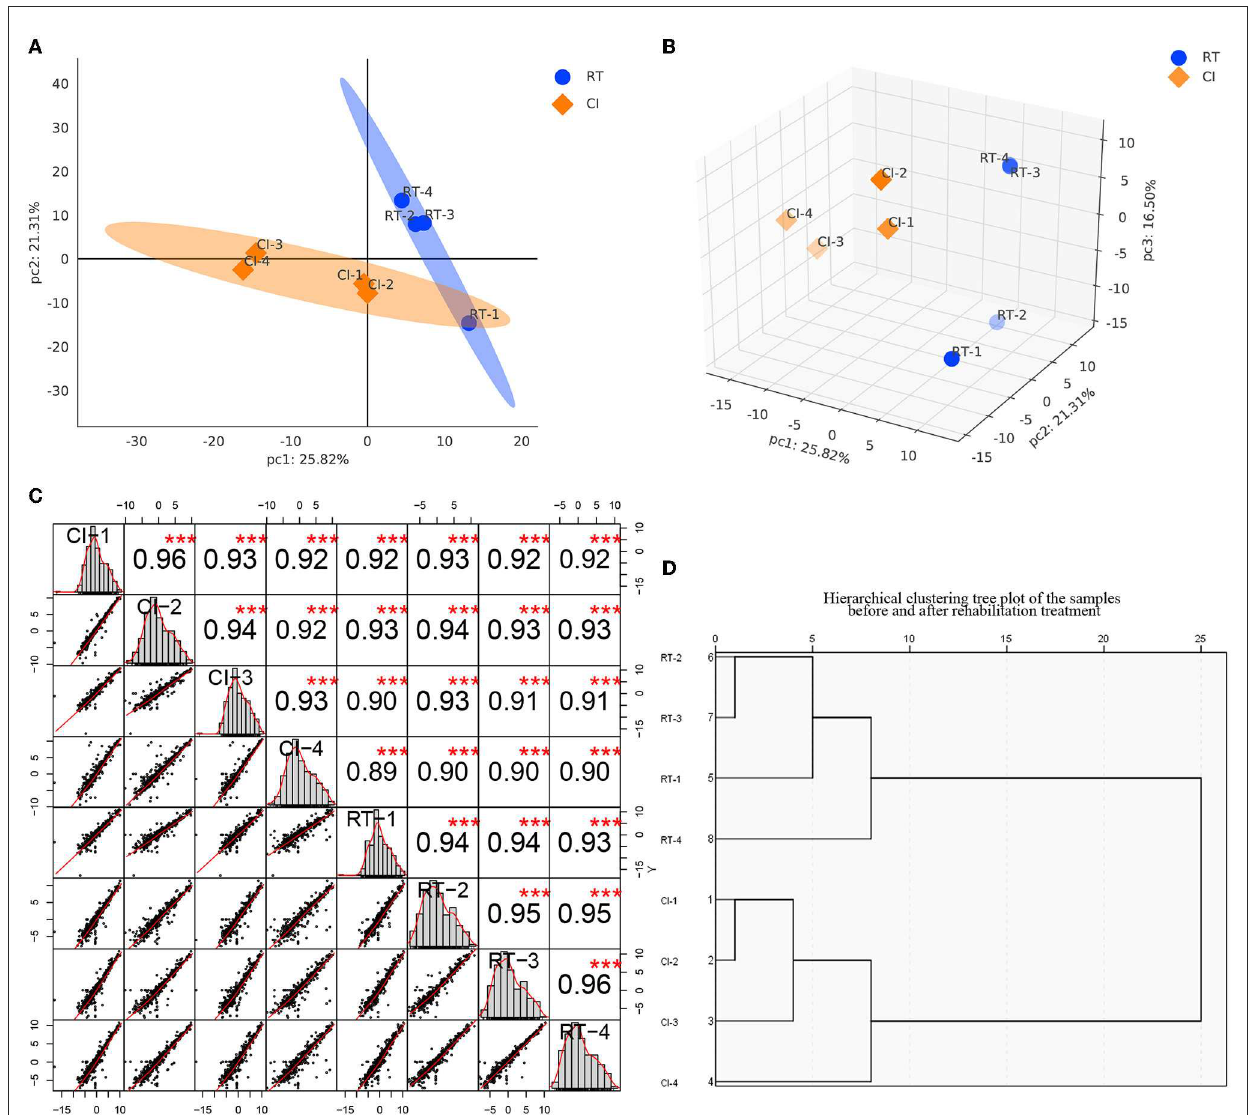
FIGURE2 (A, B) are the principal component analysis of the expression of plausible proteins before and after rehabilitation treatment [ (A) is a two-dimensional plot, while (B) is a three-dimensional plot]. Each point represents a sample, and the blue represents before treatment, while the orange is after treatment. The more distant the position of the two samples, the more significant the difference is represented. (C) Sample Correlation Analysis. The upper triangle (upper right of the diagonal line), the numbers indicate the correlation values of the two samples, * indicates the degree of significance (*** p < 0.001); the lower triangle (lower left of the diagonal line), gives the scatter plot of the expression values of the two samples, the red curve is the fitted trend, the greater the slope the stronger the correlation between the two samples; the diagonal line is the expression of the samples themselves distribution graph. (D) Sample hierarchical clustering tree diagram. Each branch end represents a sample, and samples clustered within the same branch are considered as samples expressing similar or close features, and samples not clustered into the same branch can be considered as samples with dissimilar or not close features, as measured by the Euclidean distance of the horizontal